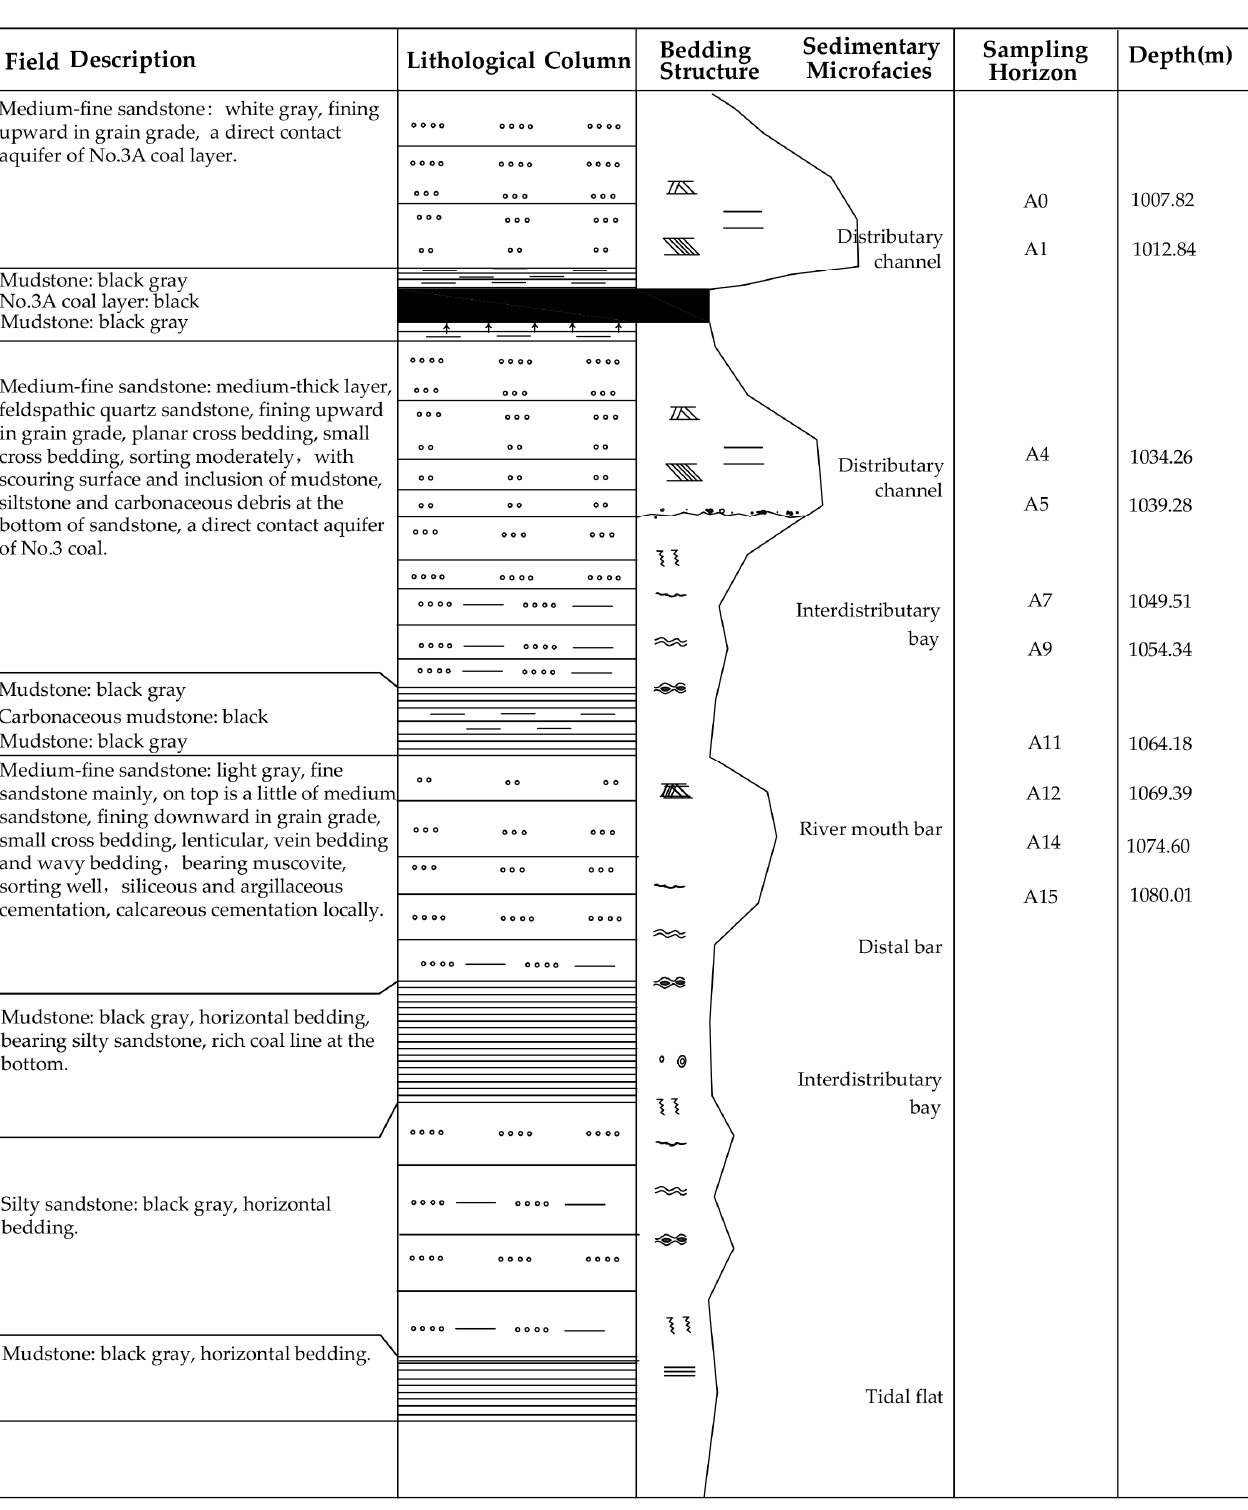
Figure A6. The sampling horizon and depth of the Shanxi Formation sandstone at No. 12 mining area of the Tangkou coal mine, the Southwest Shandong coalfield, China.